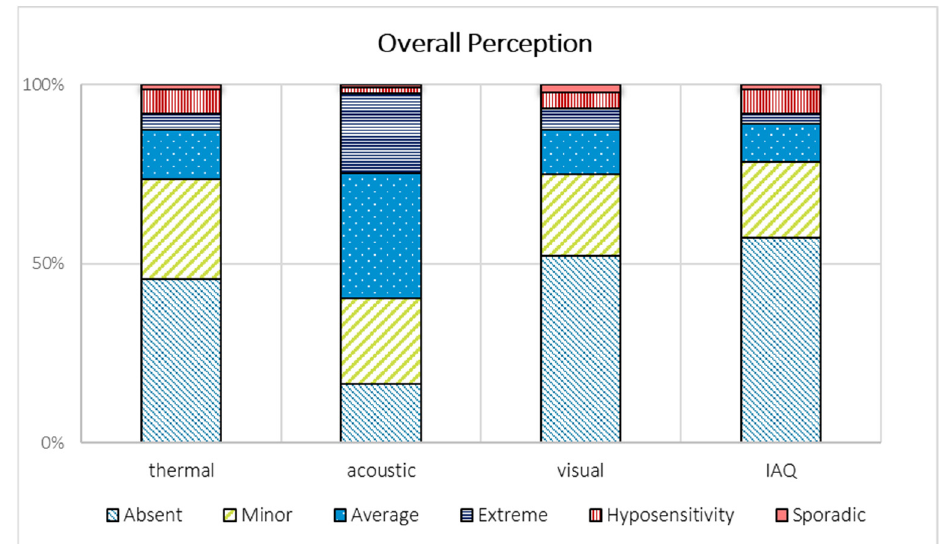
Figure 3. Overall sensitivity of people on the autism spectrum.